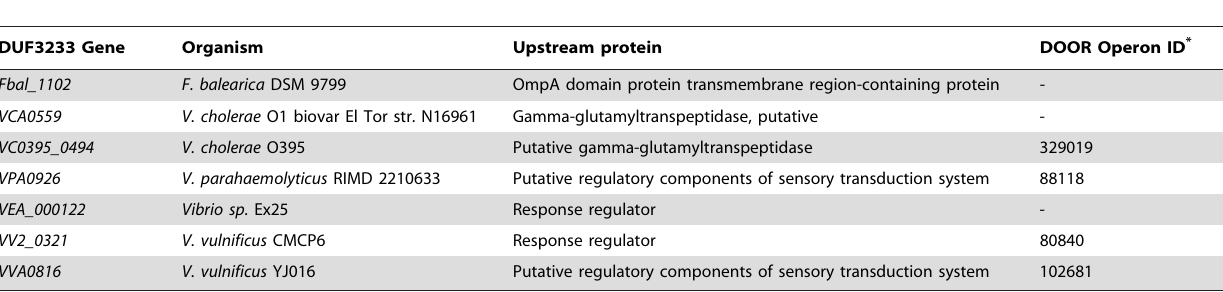
Table 1. Genomic context of DUF3233: Proteins upstream of DUF3233 in various representative organisms are organised in operons and have a probable pathogenic